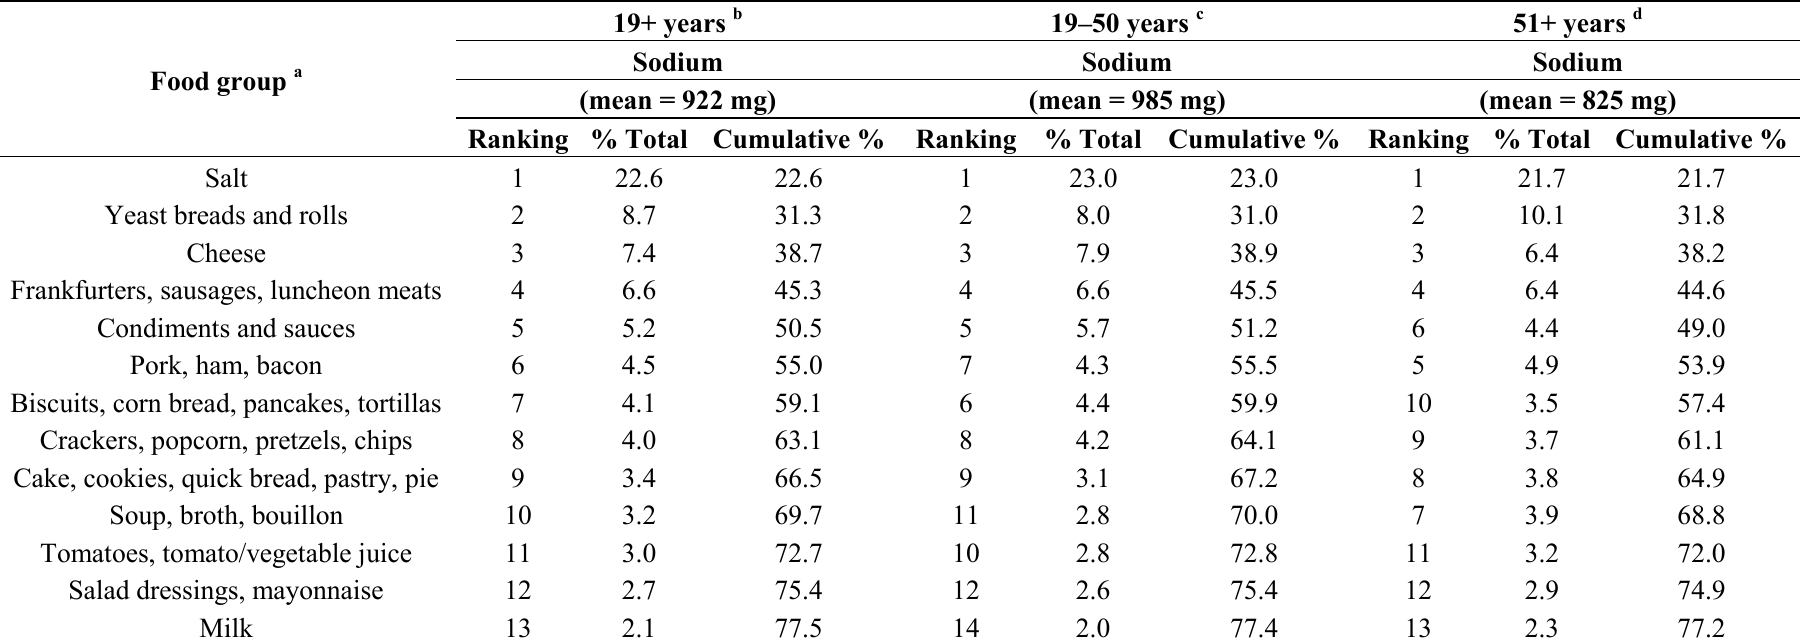
Table 11. Food sources of sodium among US adults (from NHANES